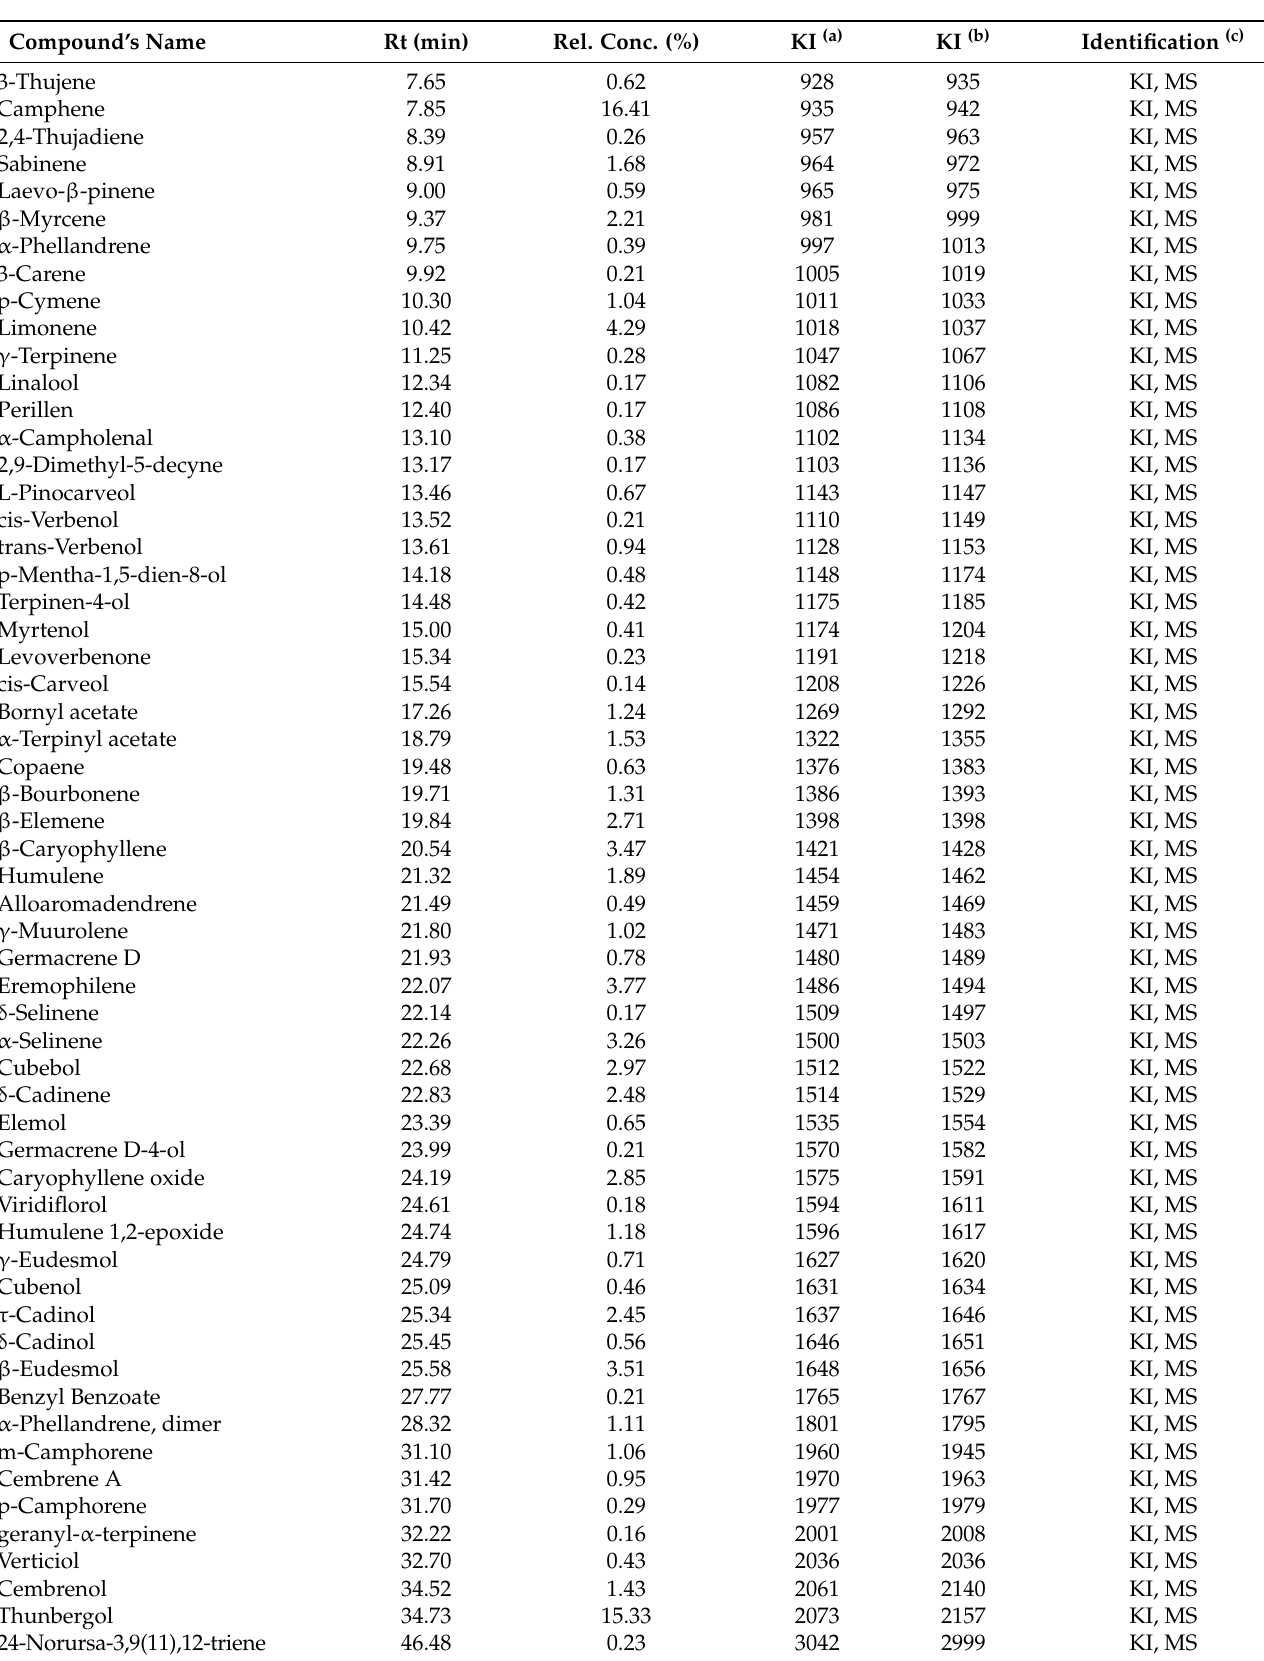
Table 1. GC-MS assessment of the essential oil of E. larica